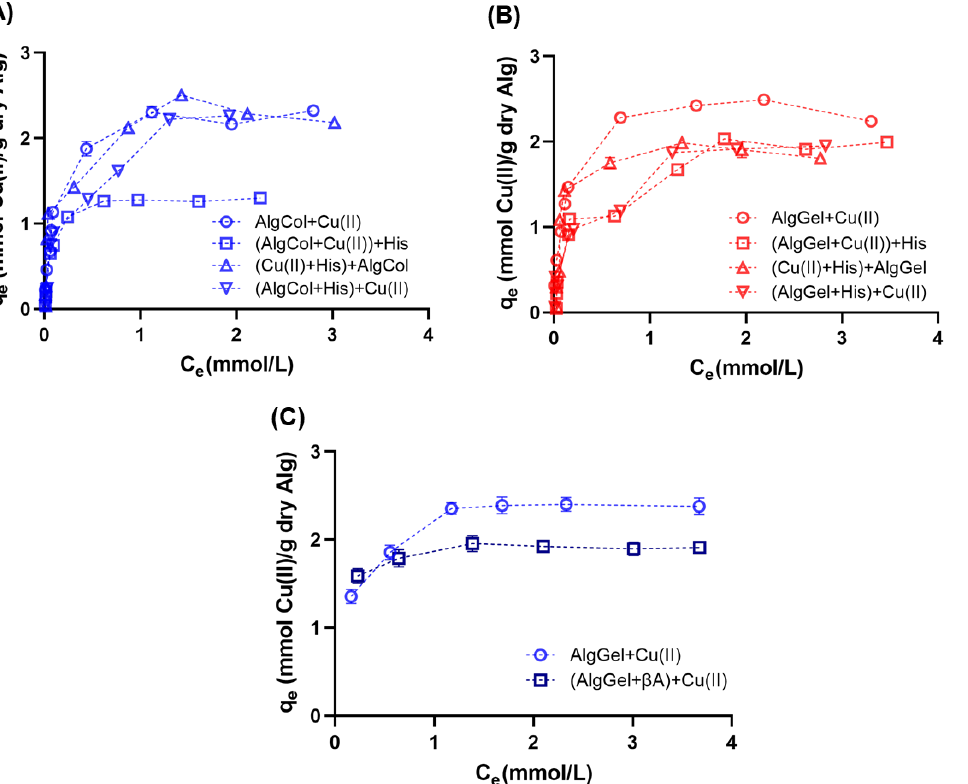
Figure 6. Adsorption isotherms of copper ions in alginate beads at 25 ◦ C and pH 5.0 using ( A ) AlgCol and ( B ) AlgGel as adsorbents. Experiments were conducted without histidine (Alg + Cu(II)), with alginate beads treated with histidine before copper adsorption ((Alg+His) + Cu(II)), with histidine mixed with copper before alginate beads addition ((Cu(II) + His) + Alg), and with histidine added after copper ion adsorption ((Alg + Cu(II)) + His). ( C ) Adsorption isotherms of copper ions in AlgGel beads at 36.5 ◦ C and pH 5.0 with and without the addition of β A to copper ions before the AlgGel